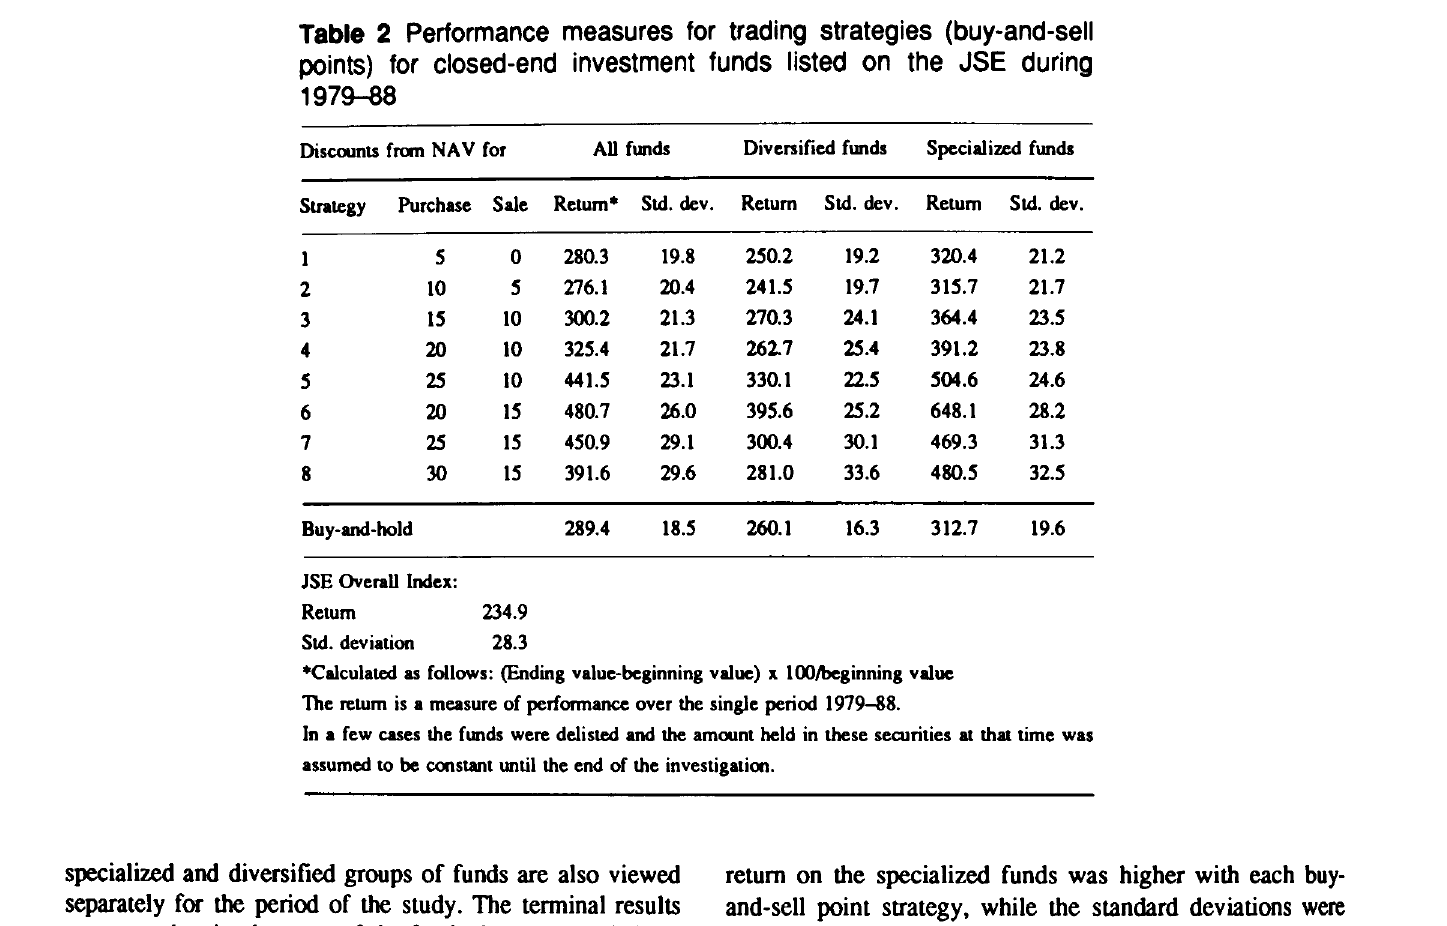
Table 2 Performance measures for trading strategies